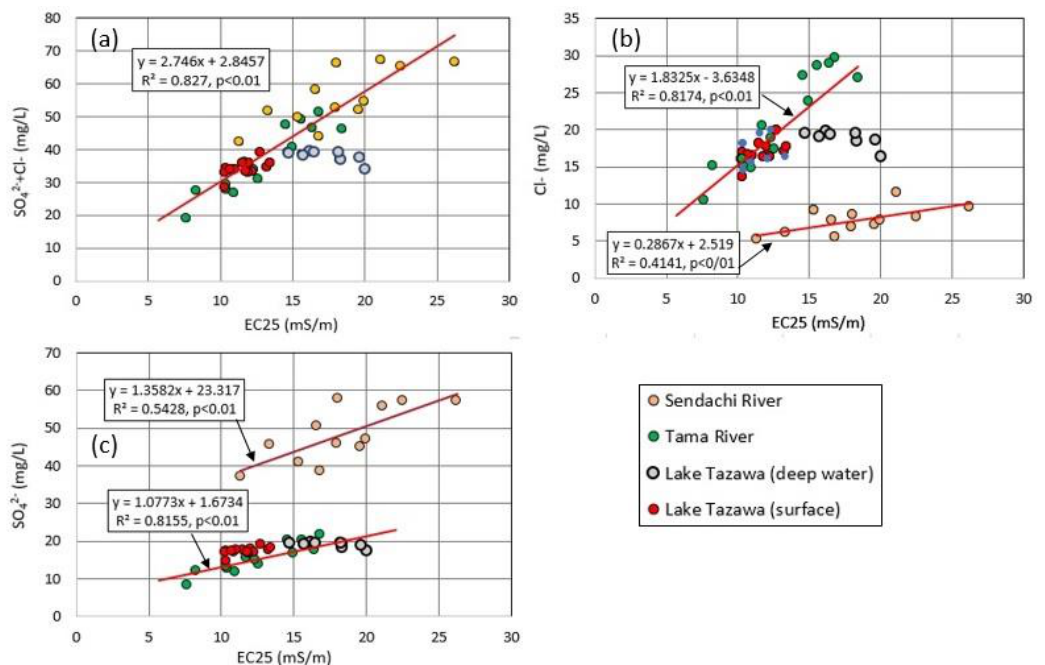
Figure 3. Relations between EC25 and ( a ) SO 42 − +Cl − concentration, ( b ) Cl − concentration and ( c ) SO 42 − concentration. The plots of lake water are separated into those of surface water and deep water at more than 50 m of depth.